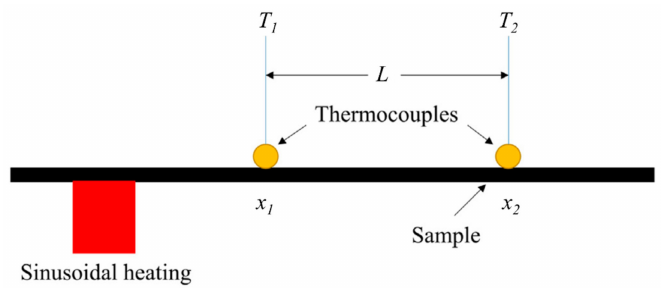
Figure 2. The theoretical measurement setup based on the Angstrom method.